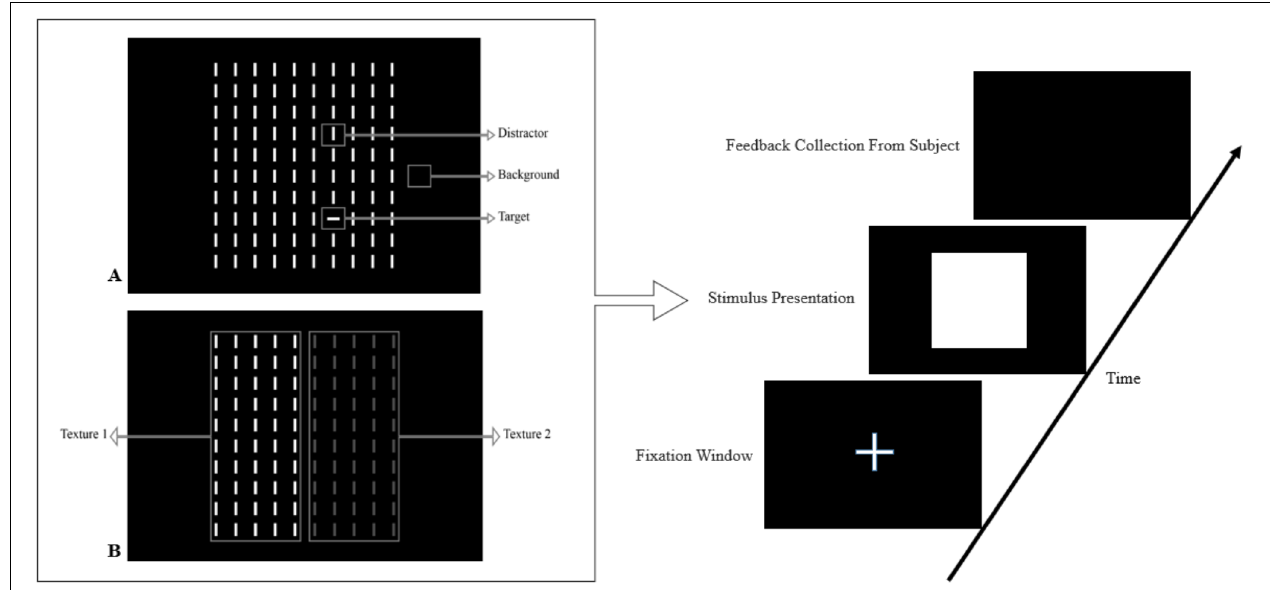
FIGURE 1 | Template of common psychophysical experiments. The right image shows the timeline. It starts with presentation of a fixation point, continues with stimulus presentation, and stops after collecting behavioral responses from subjects. The task can be visual pop-out or visual search by presenting stimulus (A) or texture segmentation by presenting stimulus (B) in the left part of the